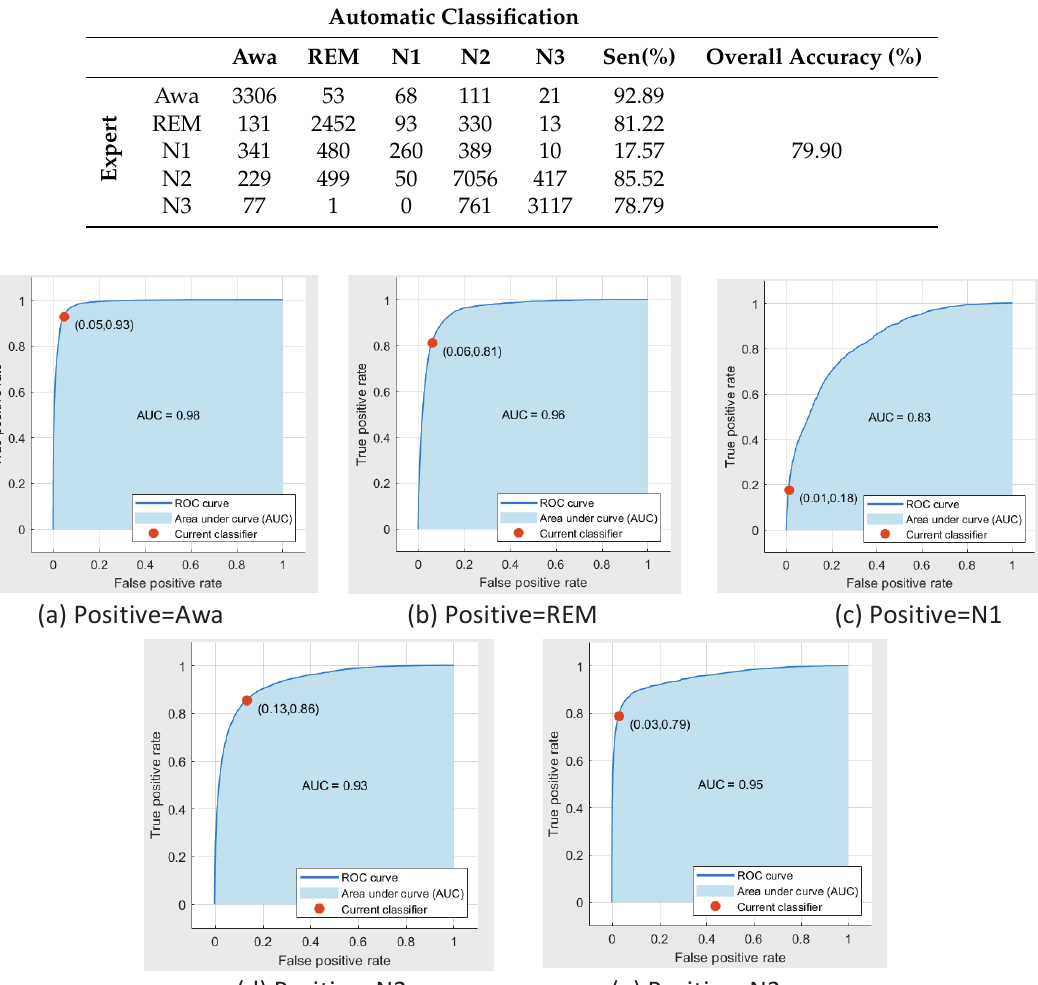
Figure 3. The ROC curve of the classifier to classify the five classes of DRMS database under the AASM